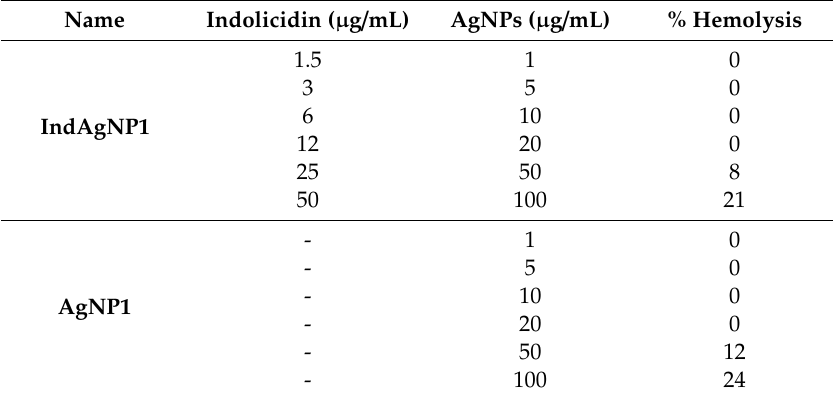
Table 4. Hemolytic activity of